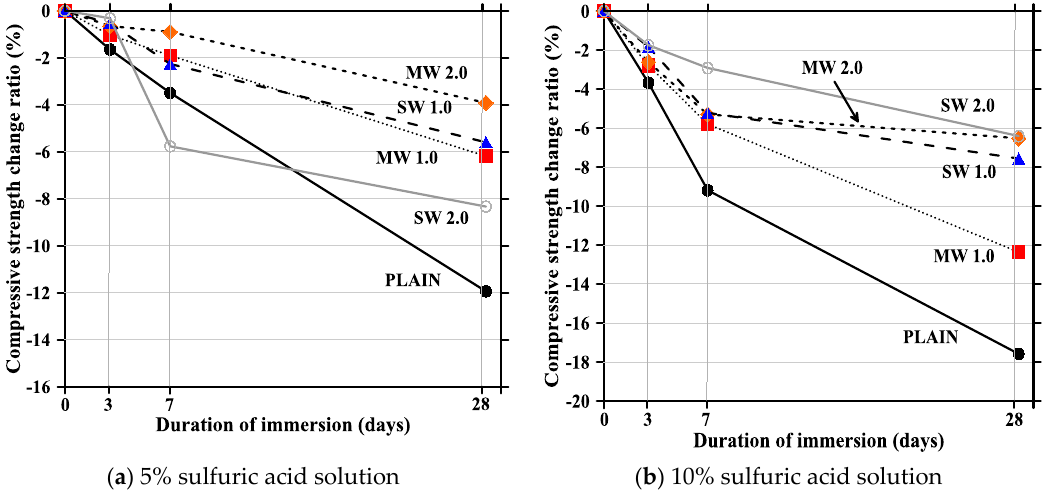
Figure 8. Compressive strength change ratio of cementitious composites immersed in sulfuric acid solution: ( a ) 5% and ( b ) 10%.